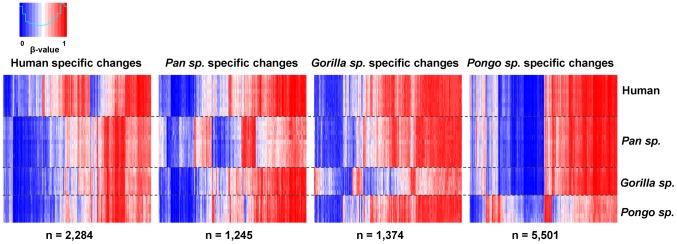
Differentially methylated CpG sites in each great ape genus.Heat maps showing genus specific differentially methylated CpG sites. We found 2,284 human-specific differentially methylated CpGs, 1,245 specific to Pan species, 1,374 specific to Gorilla species and 5,501 changes specific to Pongo species. Each vertical line represents a single CpG, with each row showing the β-value obtained in each individual tested.